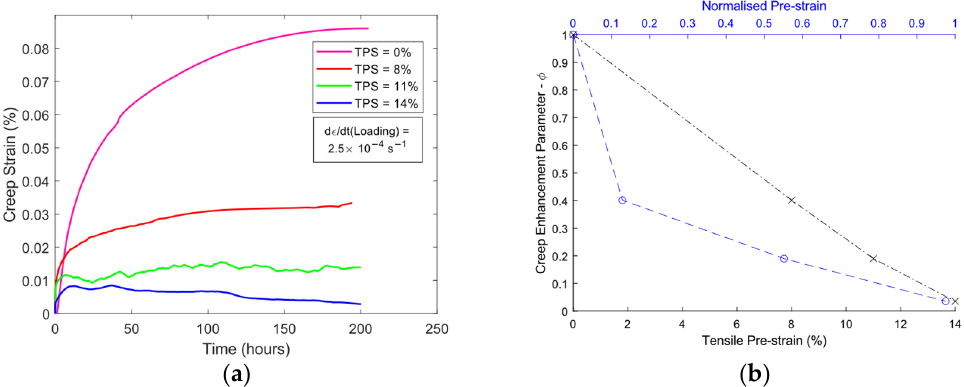
Figure 4. ( a ) Creep tests of pre-strained specimens at 280 MPa. ( b ) Effect of pre-strain on creep rate, parameter definition included in Section 3.2.